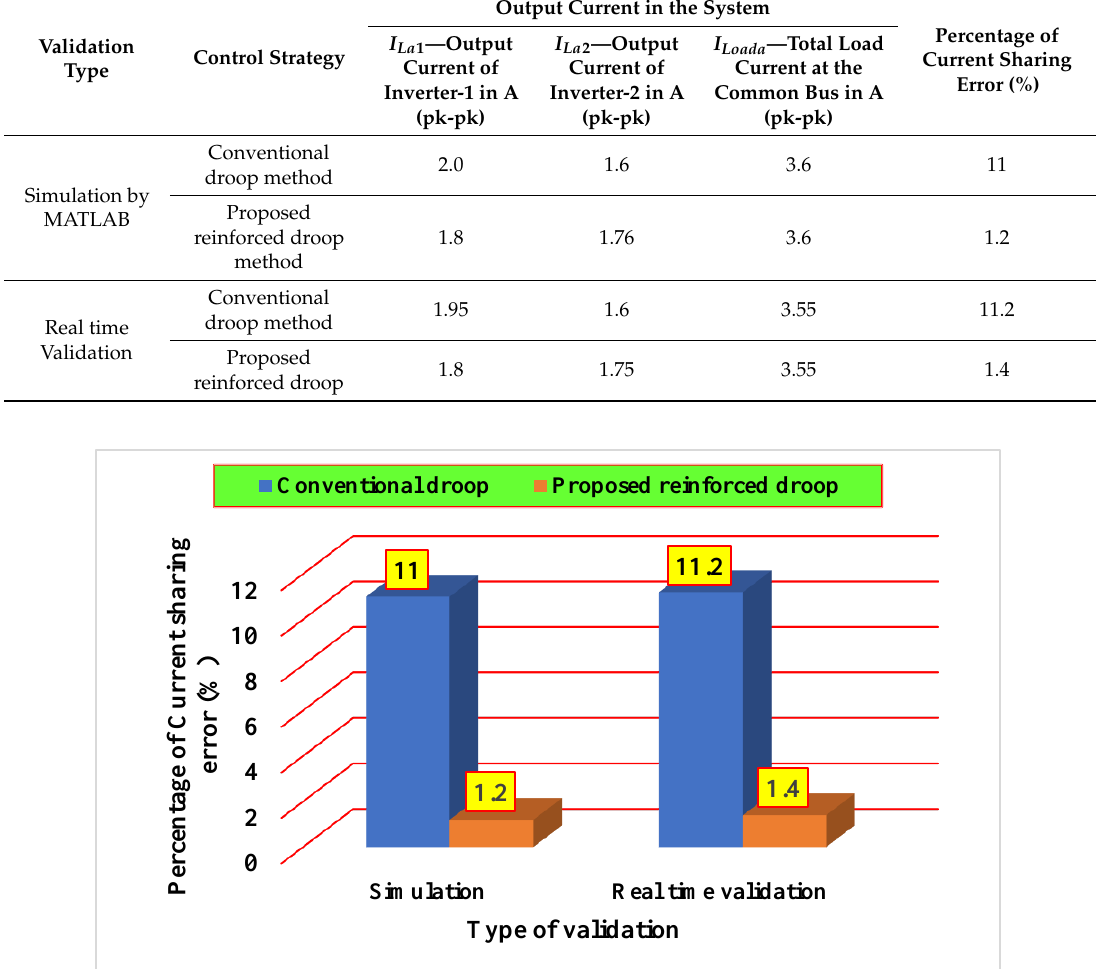
Figure 33. Comparison of conventional and proposed reinforced droop control.